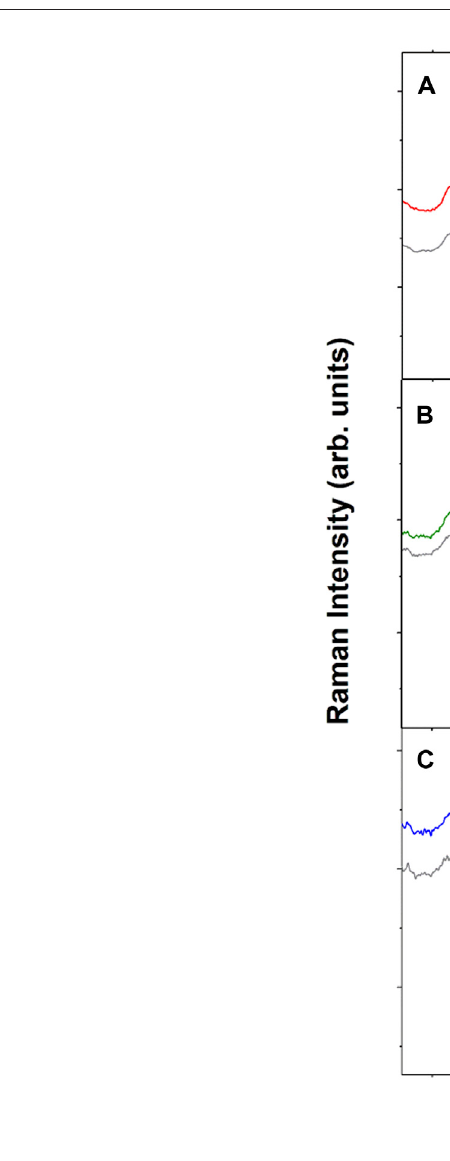
FIGURE 3 | Background (grey traces) and BPE SERS spectra (red, green and blue traces) of the printed sensors. All background spectra were displayed as grey traces. (A) . SERS spectra obtained from 80 nm AuNP ink 8-printing passes sensors. The tick increment is 5,000 counts. (B) . Spectra from 50 nm AuNP ink 8-printing- passes sensors. The tick increment is 2,000 counts. (C) . Spectra from 50 nm AuNP ink 6-printing passes sensors. The tick increment is 1,000 counts. All spectra were acquiredwith2 sintegrationand fi veaccumulations.Eachspectrumshownhereistheaverageofspectraobtainedfrom10randomspotsfromtheprintedsensor. All spectra were acquired with handheld Raman analyzer. Spectra have been offset for